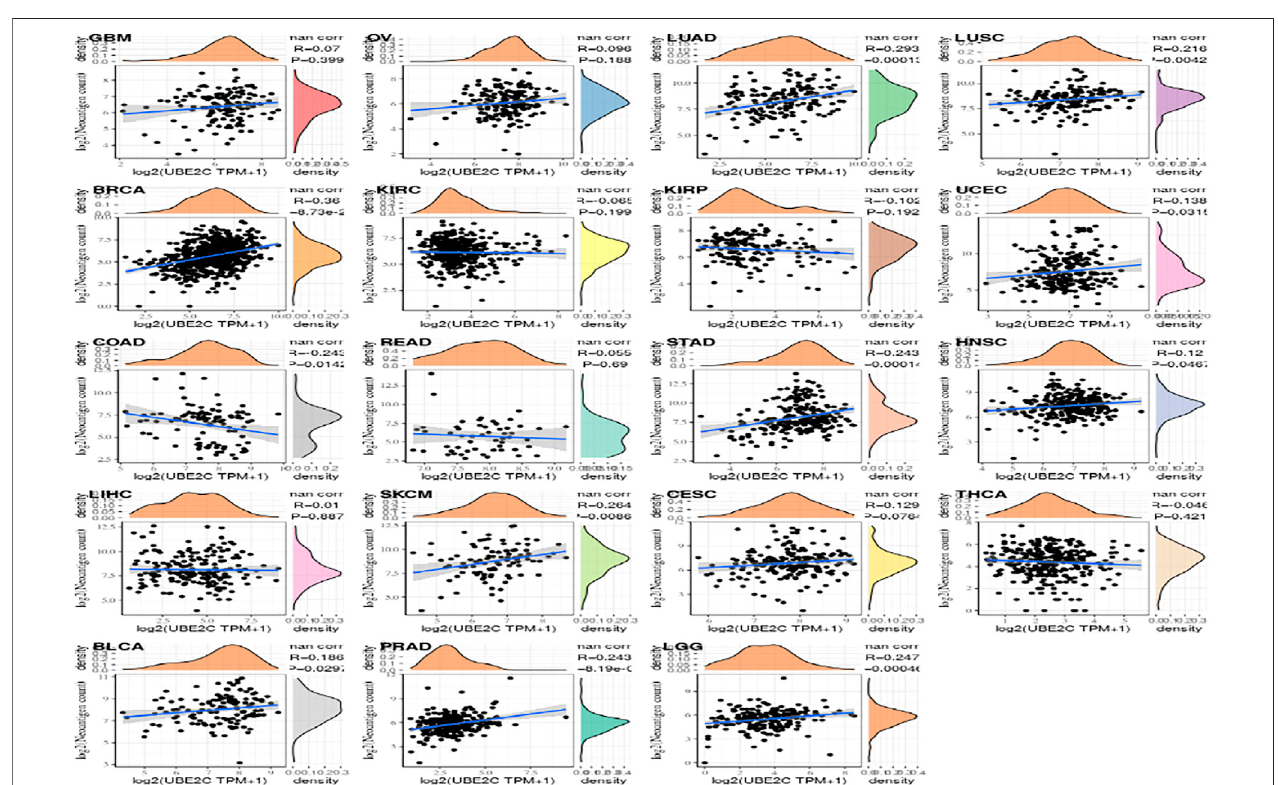
FIGURE 10 | The relationship between gene expression and the number of antigens.